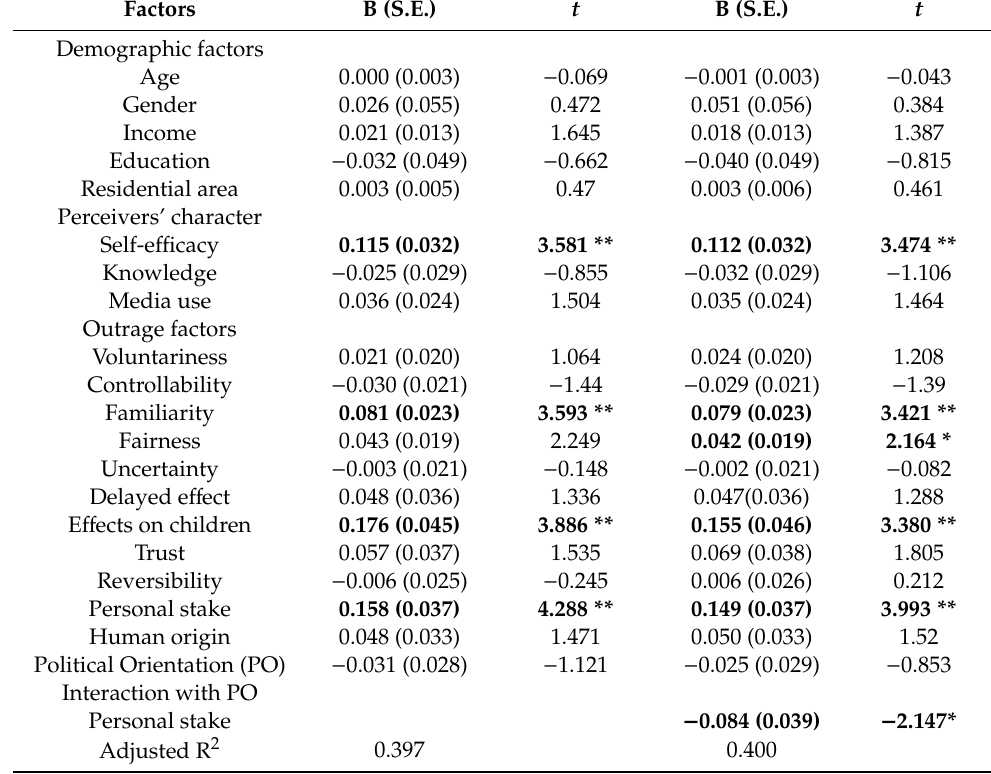
Table 3. The influences on the South Koreans’ climate change risk